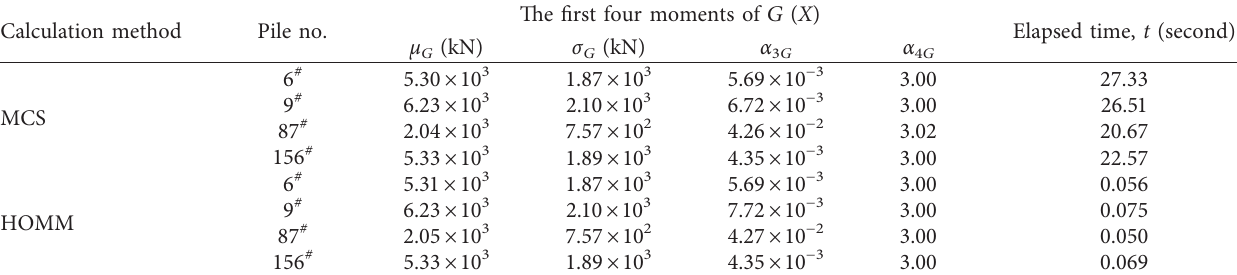
Table 4: Calculating comparison between HOMM and